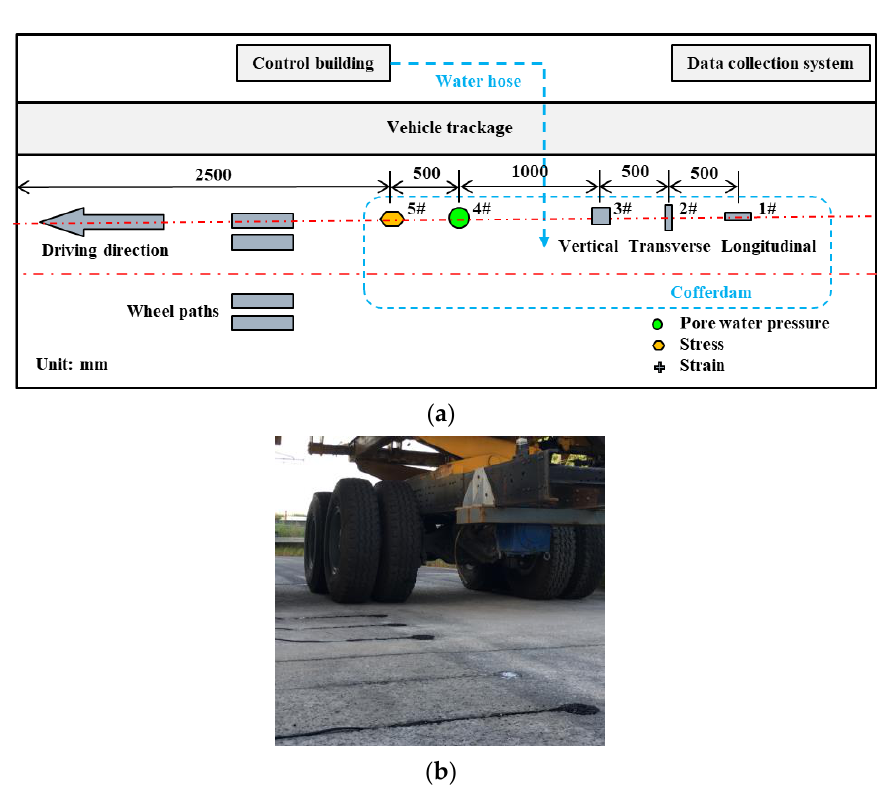
Figure 5. Layout of the buried sensors: ( a ) Horizontal layout; ( b ) Relative position between vehicle tires and buried sensors.